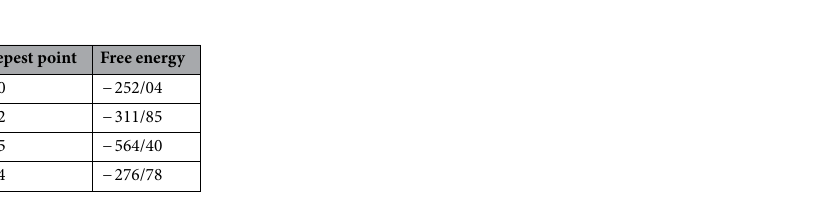
Table 4. Deepest point (nm) and Free energy (kJ/mol) of the adsorption of single amino acid on